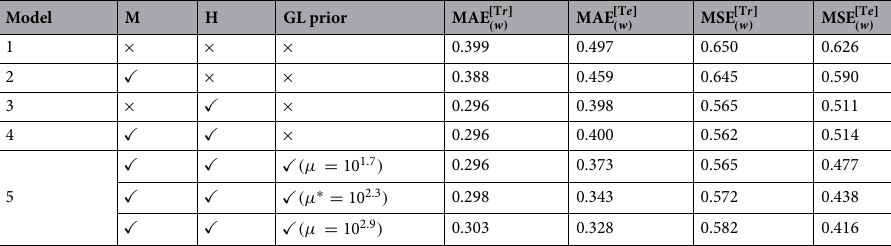
Table 8. Training and testing errors of Models 1–5 for real-world data in China. The formulas of errors are detailed in Sect. B (Eq. (S5)) of Supplementary Information. The remarks for Columns 1–4 are the same as those in Table 4. In addition, the choice of µ = 10 1.7 , 10 2.3 , and 10 2.9 in Model 5 has been explained in Fig. 9. Note that the validation errors are minimized at µ ∗ = 10 2.3 as shown in Fig. 12.